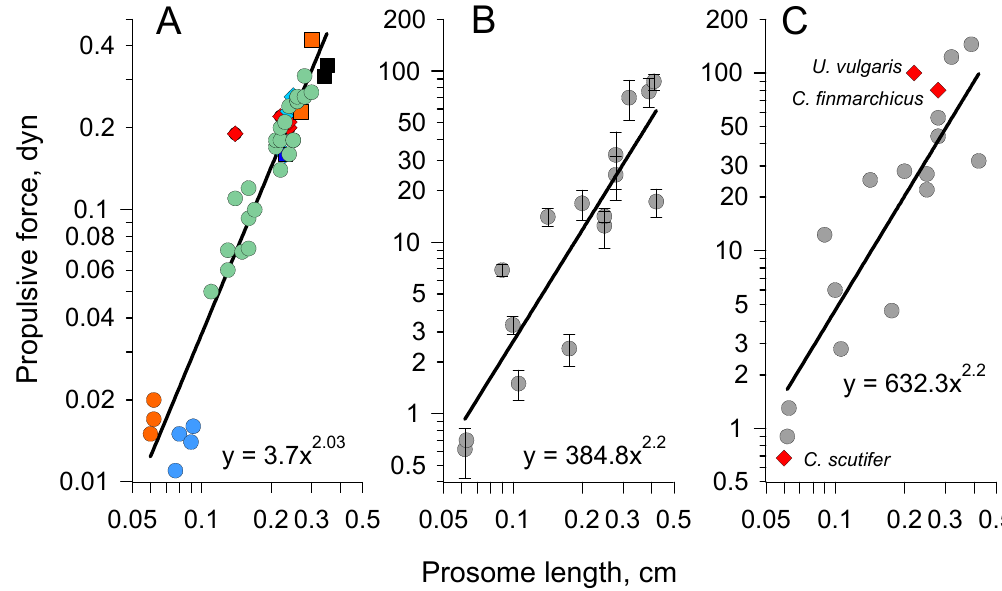
Figure 11. Propulsive force created by the Black and Mediterranean Seas copepods attached to semiconductor force sensor at 21 ± 2 °C (Table 3). ( A ): Mean resulting force of cephalic appendages in Paracalanus parvus ( ● ), Pseudocalanus elongatus ( ● ), Calanus helgolandicus ( ● ), Phaenna spinifera ( ● ), Pontella mediterranea ( ♦ ), Pleuromamma abdominalis ( ♦ ), Euchaeta marina ( ■ ), and Euchirella messinensis ( ■ ) (from Svetlichny 1993a). ( B ): mean tractive force of swimming thoracic legs during the escape reaction in Paracalanus parvus , Acartia clausi , Calanus helgolandicus , Pontella mediterranea , Undinopsis similis , Scolecithrix Bradyi , Nannocalanus minor , Pleuromamma abdominalis , Eucalanus attenuates , and Euchirella messinensis . ( C ): Maximum values of the species from ( B ) and species from literature data on Cyclops scutifer [33], Undinula vulgaris [34], and Calanus finmarchicus [61].